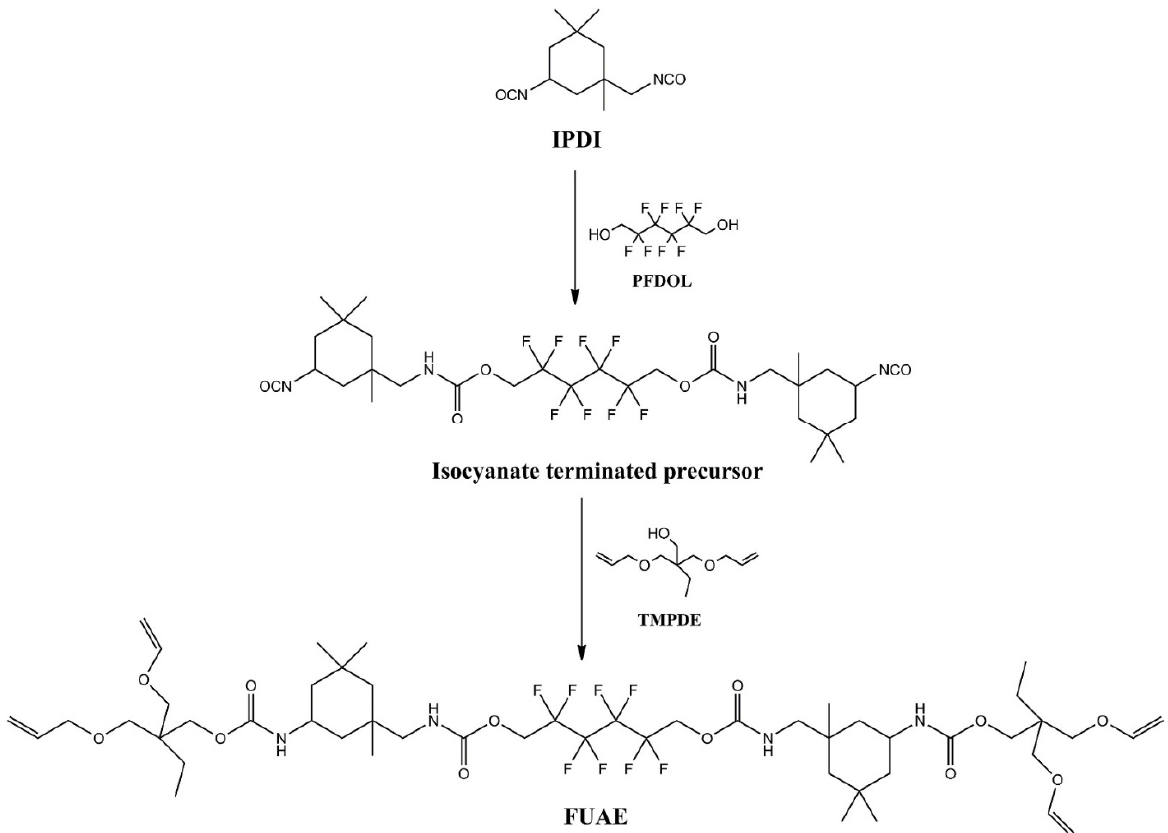
Figure 25. Synthesis route of fluorine containing urethane-based allyl ether multiene monomer (FUAE), as described by Fu et al. Reprinted with permission from [62]; published by Elsevier, 2019.